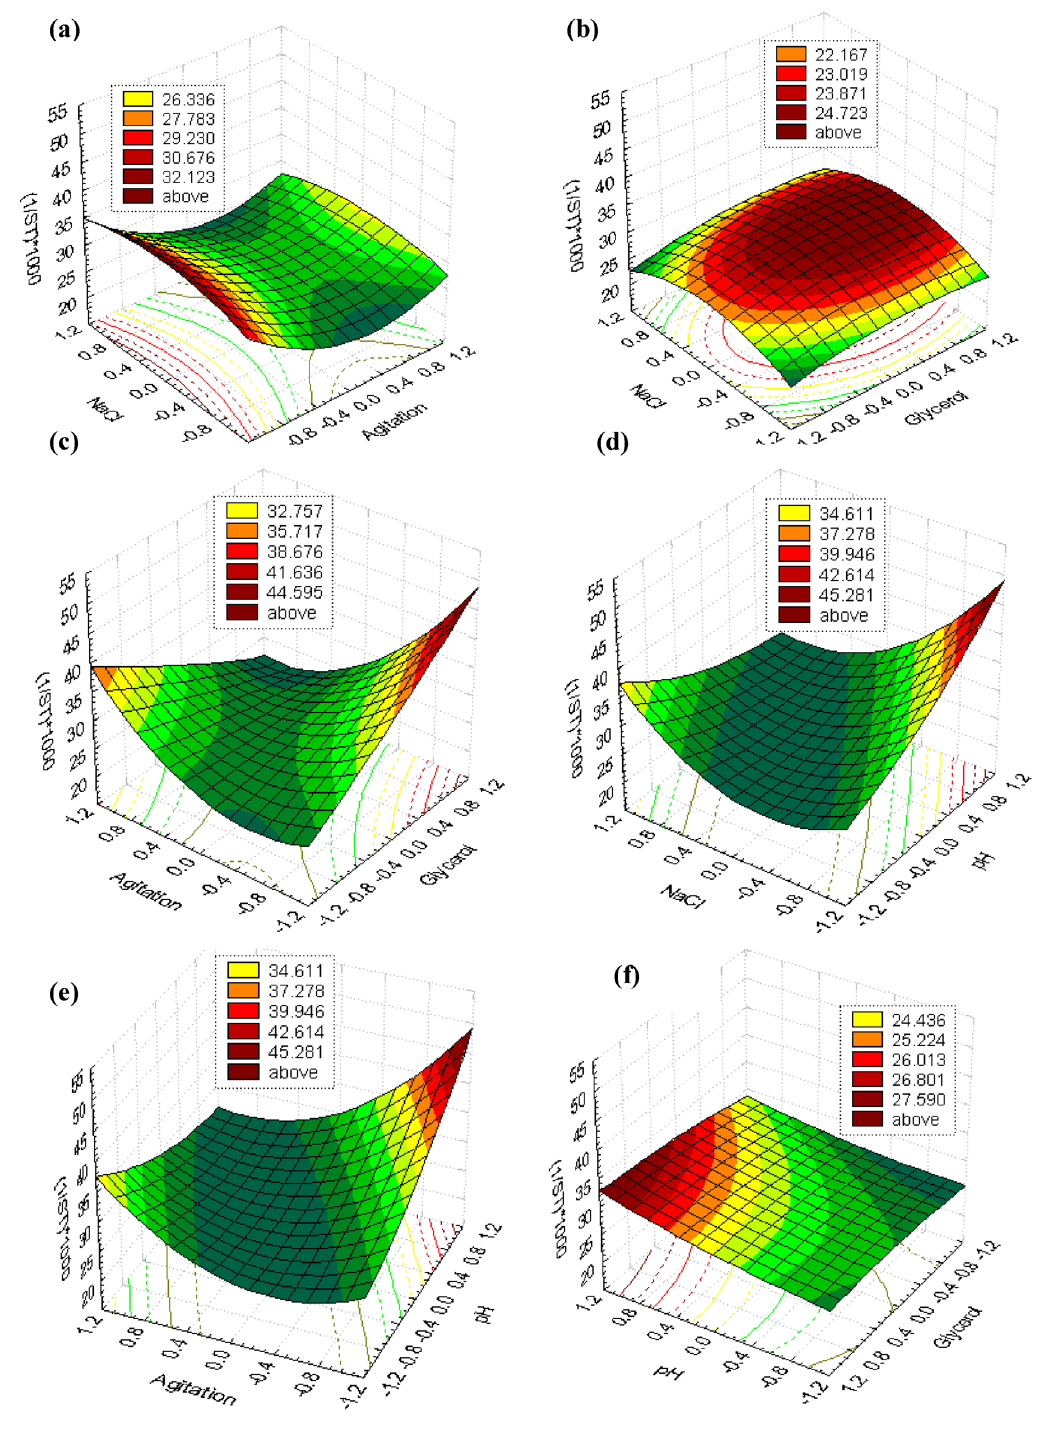
Figure 3. Three-dimensional surface and contour plots showing the relationships between the tested variables and the biosurfactant as a response in a form of [(1/ST) × 1000] produced by Natrialba sp. M6. ( a ) Showed that at low agitation value and middle value of NaCl gave the highest biosurfactant production level. ( b ) Showed that at high glycerol value and middle value of NaCl gave the highest biosurfactant production level. ( c ) Showed foci for maximum level of biosurfactant production at high glycerol value and low agitation. ( d ) Indicated that at middle NaCl and high pH values the maximum production was achieved. ( e ) Showed the maximum response at high pH and low agitation and ( f ) showed foci for maximum level of biosurfactant production at high values of both glycerol and